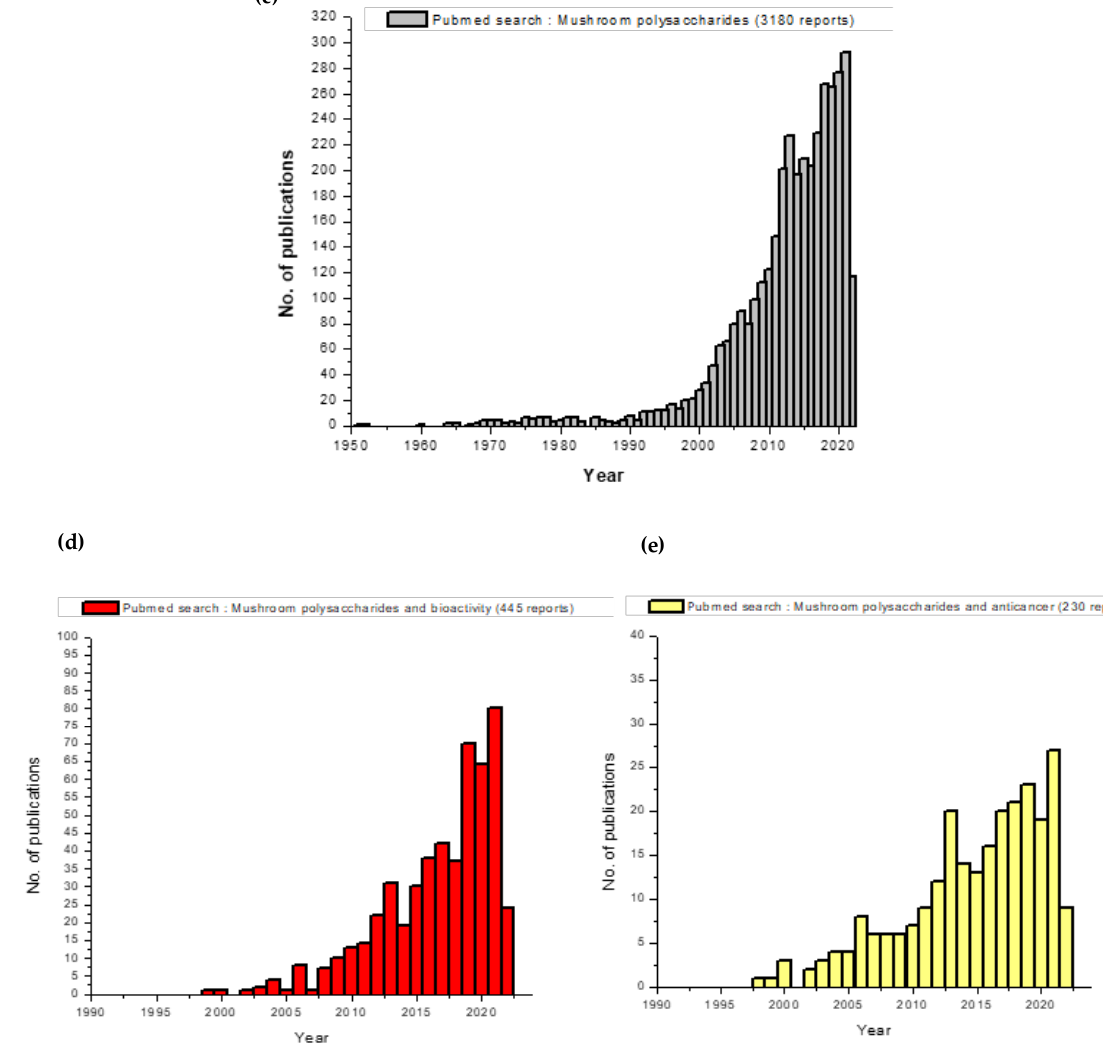
Figure 4. A pubmed-based search showing the updated trend in medicinal mushroom research. The keywords that defined the search were ( a ) mushroom and bioactivity (1320 reports); ( b ) mushroom and anticancer (693 reports); ( c ) mushroom polysaccharides (3180 reports); ( d ) mushroom polysaccharides and bioactivity (445 reports); and ( e ) mushroom polysaccharides and anticancer (230 reports) .